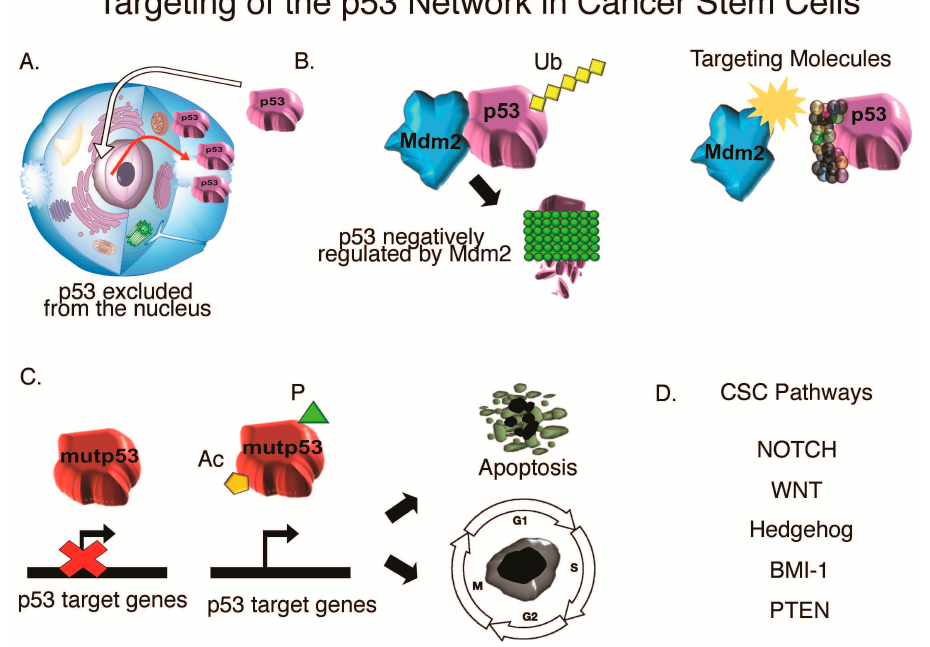
Figure 4. Targeting of the p53 Network in cancer stem cells. ( A ) Restoring p53 transcriptional activity be preventing/restoring p53 exclusion from the nucleus; ( B ) targeting molecules to disrupt the p53-Mdm2 interaction to prevent p53 degradation; ( C ) restoring mutant p53 function by modifications; ( D ) targeting CSC pathways.